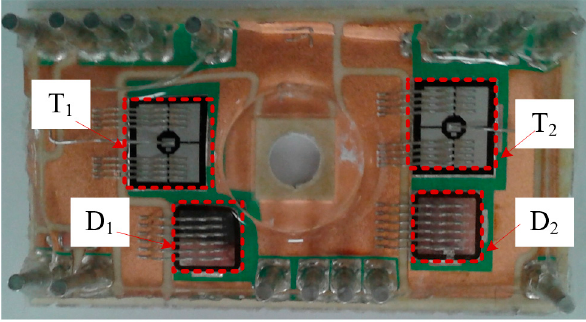
Figure 3. Image of the IGBT module under study.